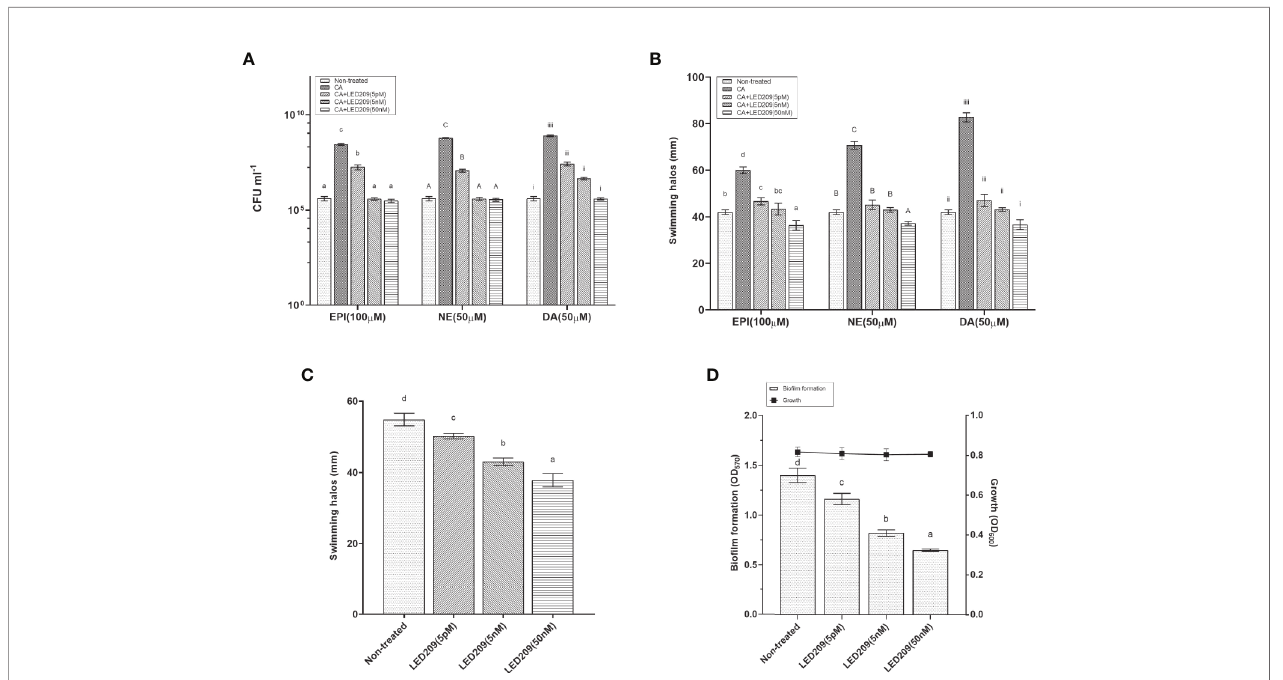
100 nM of LED209 during the following 24 h, respectively.